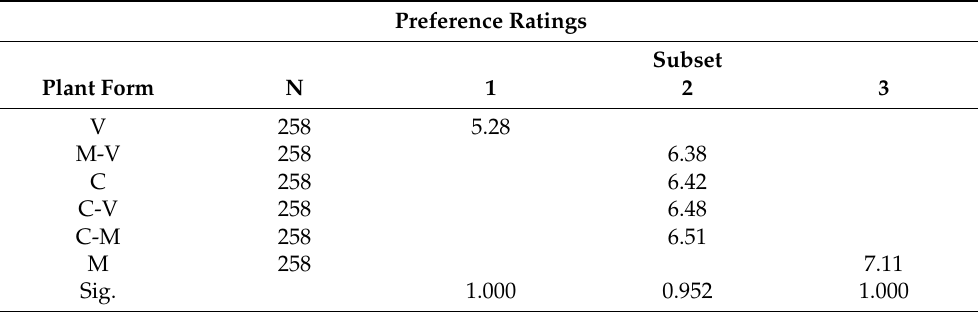
Table 4. Differences in aesthetic preference ratings of vegetation landscapes composed of plants of different